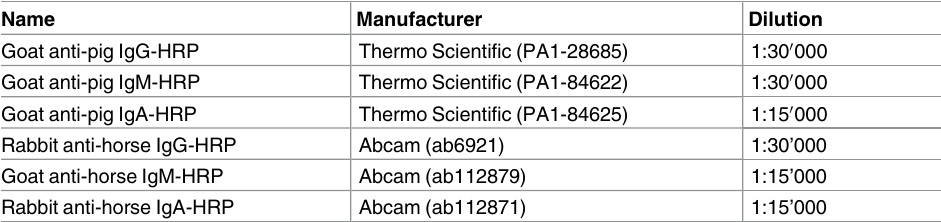
Table 2. Used antibodies and dilutions for Western Blot